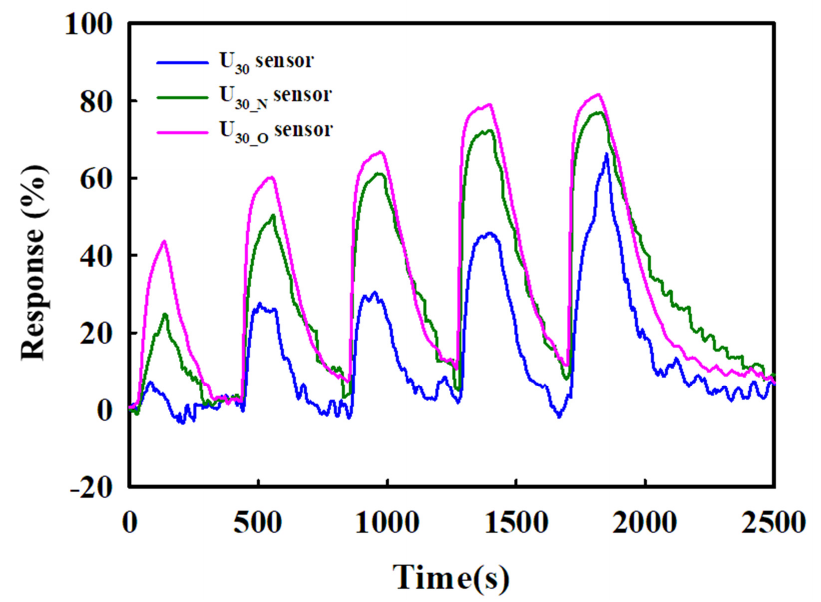
Figure 8. Response characteristics of U 30 , U 30-N , and U 30-O for 1, 5, 10, 30, and 50 ppm toluene.